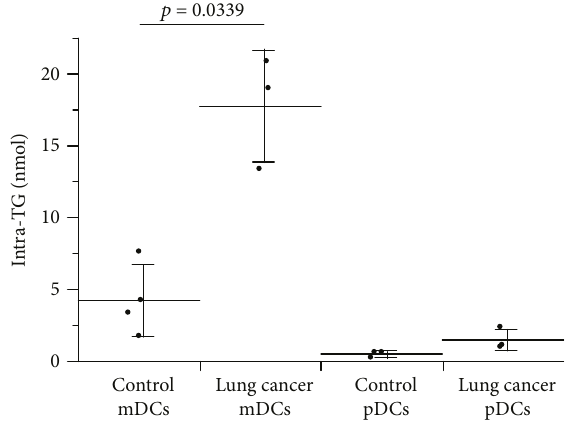
Figure 9: Mixed lymphocyte reaction (MLR). Peripheral blood DCs were cocultured with allogenic native T cells at a ratio of 1: 6, and the rate of T cell proliferation was measured using BrdU. A lower MLR was observed in the stage IV lung cancer patient mDCs ( n = 4 ) than in control mDCs ( n = 4 ). These data represent means ± SEM of four independent experiments.